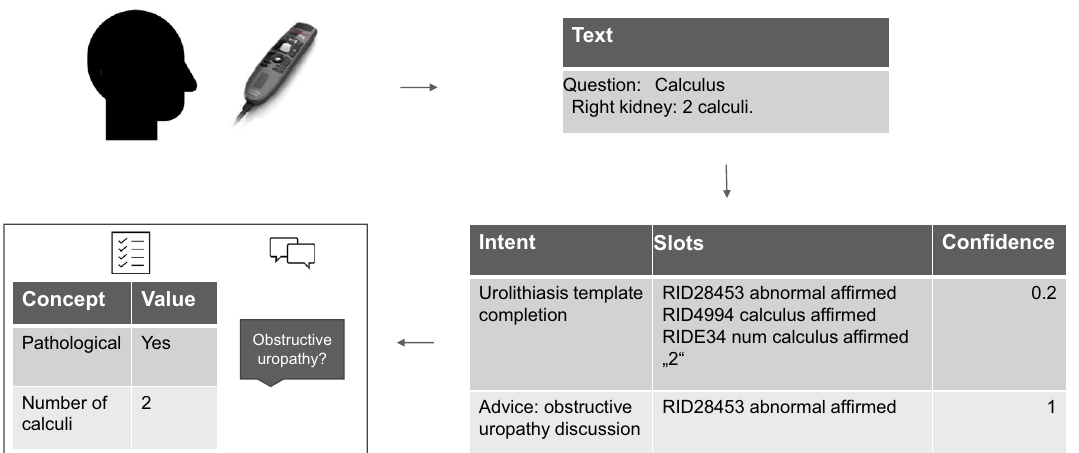
Fig. 5 Functionality of the dialogue system. Text is translated into structured content of intents and slots. The template is completed using RadLex terms. Advice intents are returned to the user. A confidence is computed for each